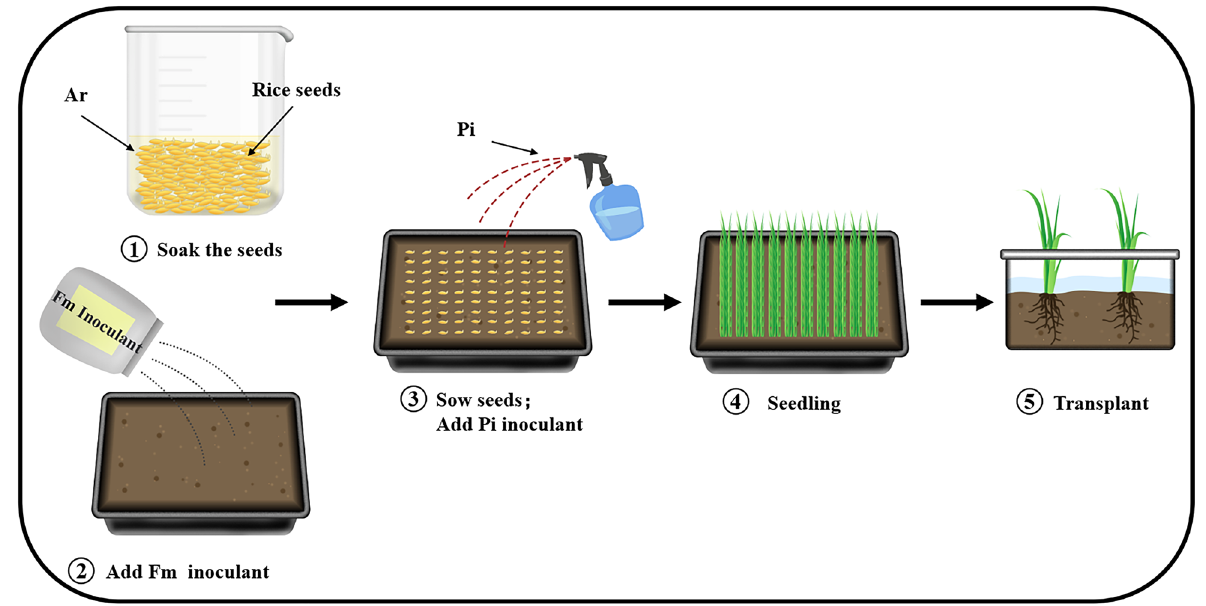
Fig. 8 Nursery process of AMF compound